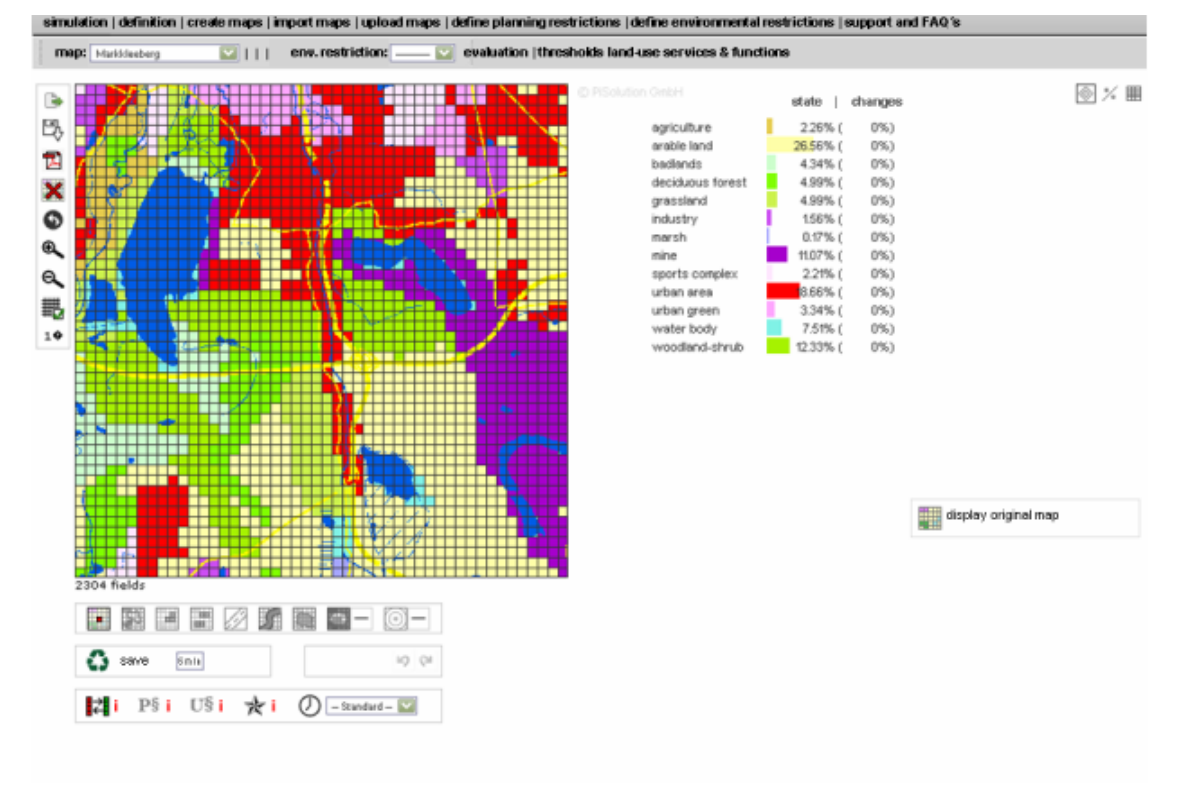
Fig. 4 . User interface of Pimp your landscape